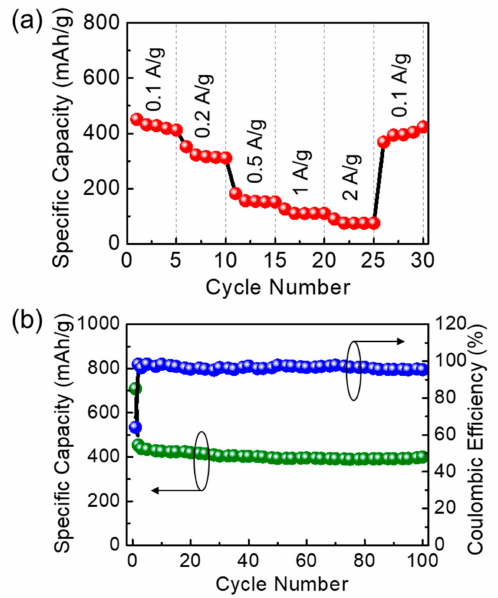
Figure 5. ( a ) Rate performance at various J a , and ( b ) cyclic performance with its corresponding coulombic e ffi ciency at J a of 0.1 A / g for the LIB device with the anode material of IMP-GC nanoflakes.